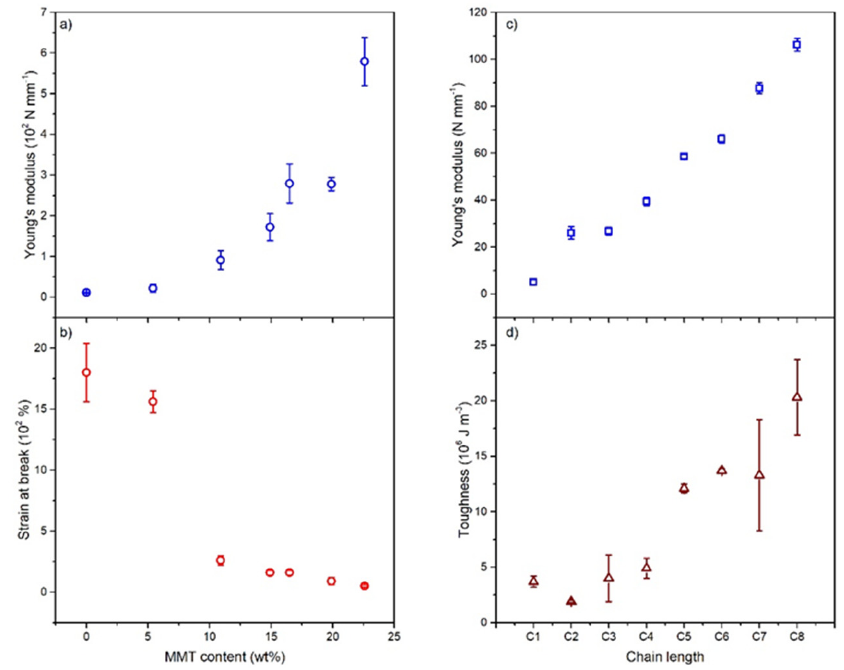
modulus and ( d ) toughness as a function of the chain length of the grafted PMMA. Adapted from Ref.